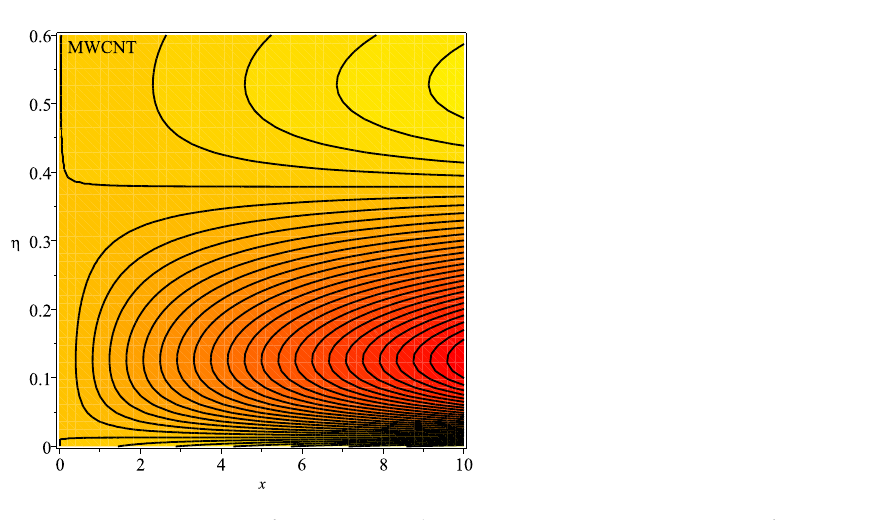
Figure 24. Repercussion of M egt = 1 with φ = 0.1, κ = 2, Ω = 1, ω = π /2, N = 10, Υ = 0.2, Pr = 100 on the isotherm.